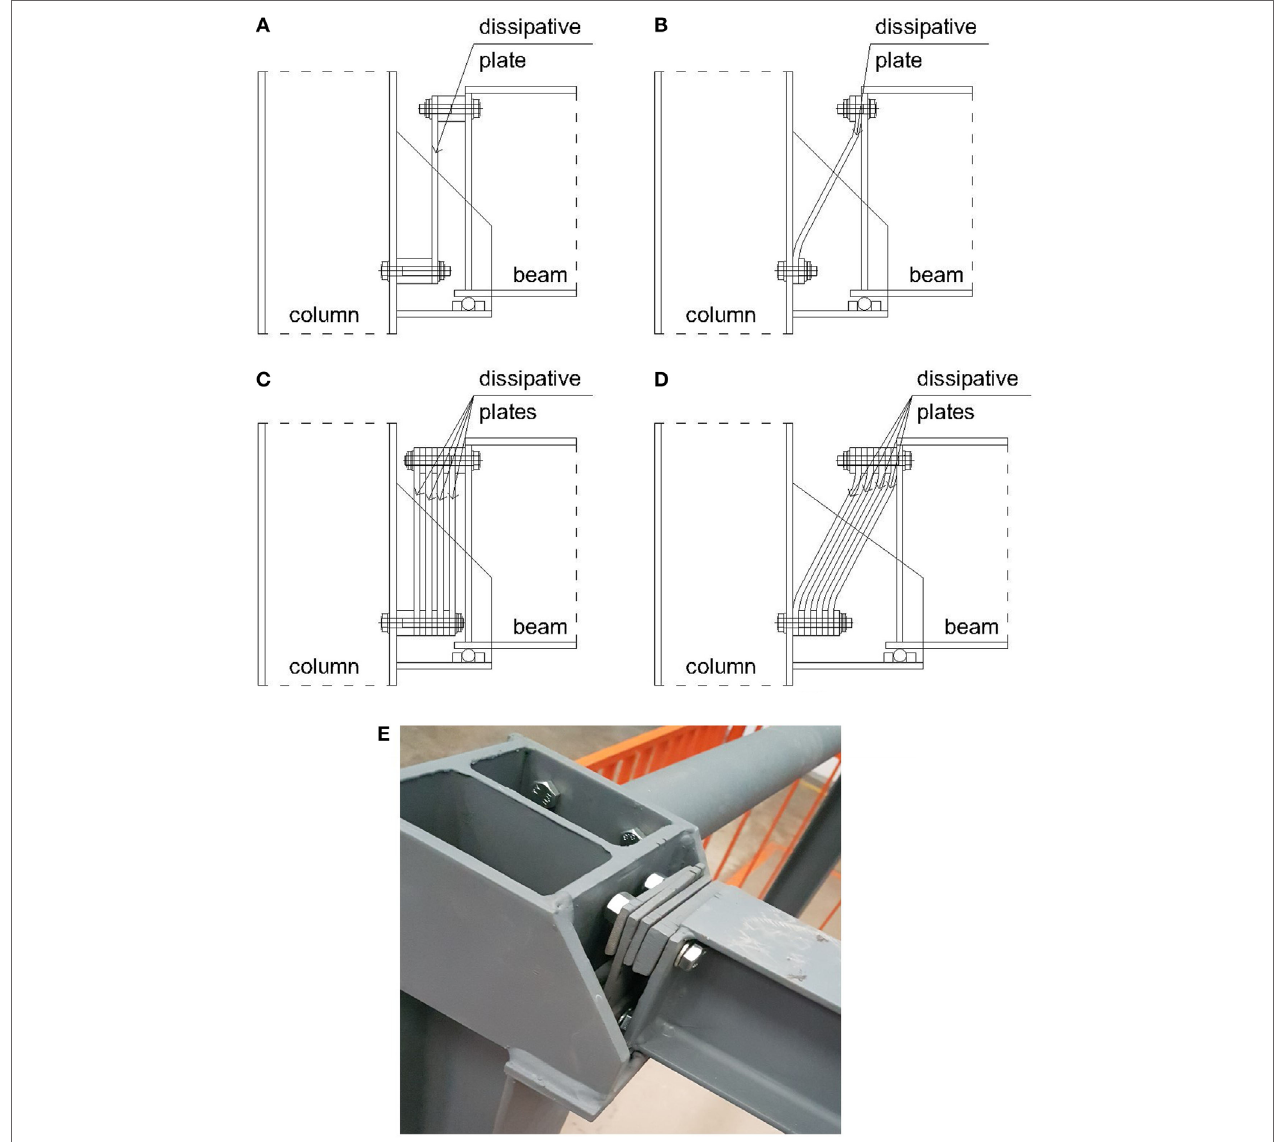
FiGUre 1 | Beam-to-column connections with different versions of dissipative plates: (A) one straight plate, (B) one bent plate, (c) multiple straight plates, (D) multiple bent plates, and (e) one straight plate—experimental